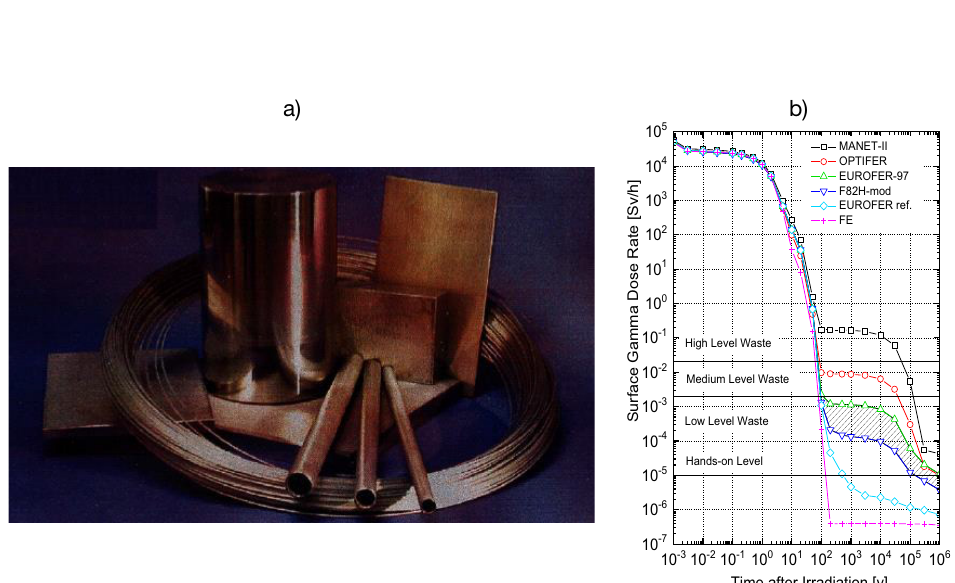
Fig. 7. – (a) Picture of EUROFER components (by courtesy of EUROfusion) and; (b) contact dose rate vs. time for different steels from ref.